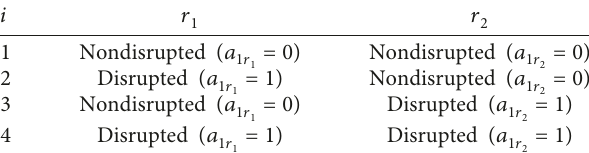
Table 1: Example of disruption plans when two paths are